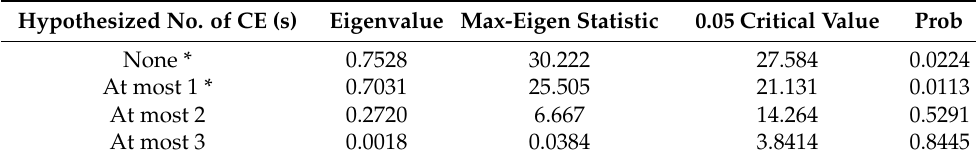
Table 4. Johansen Unrestricted Cointegration Rank Test (Maximum Eigenvalue).